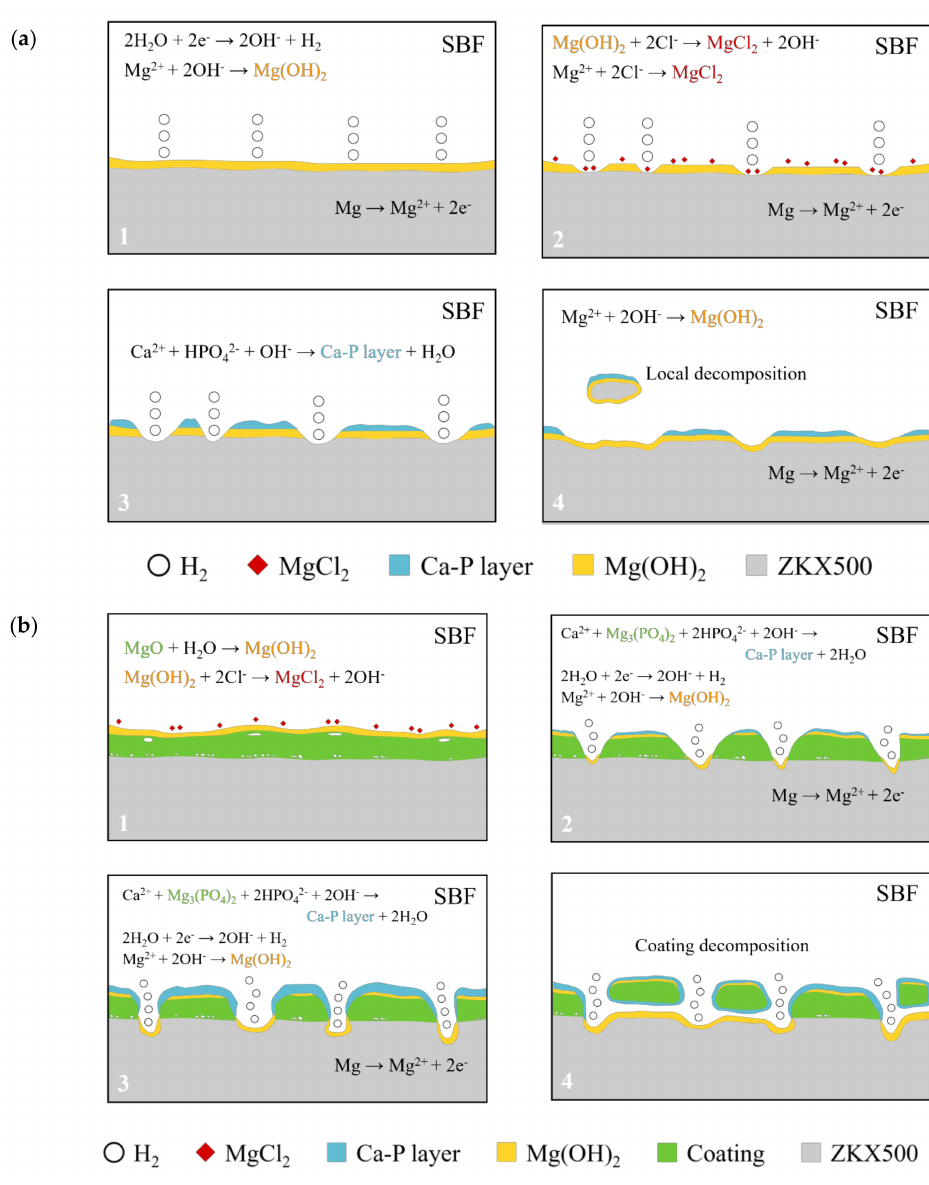
Figure 12. Degradation mechanism of ( a ) F and ( b ) FP in